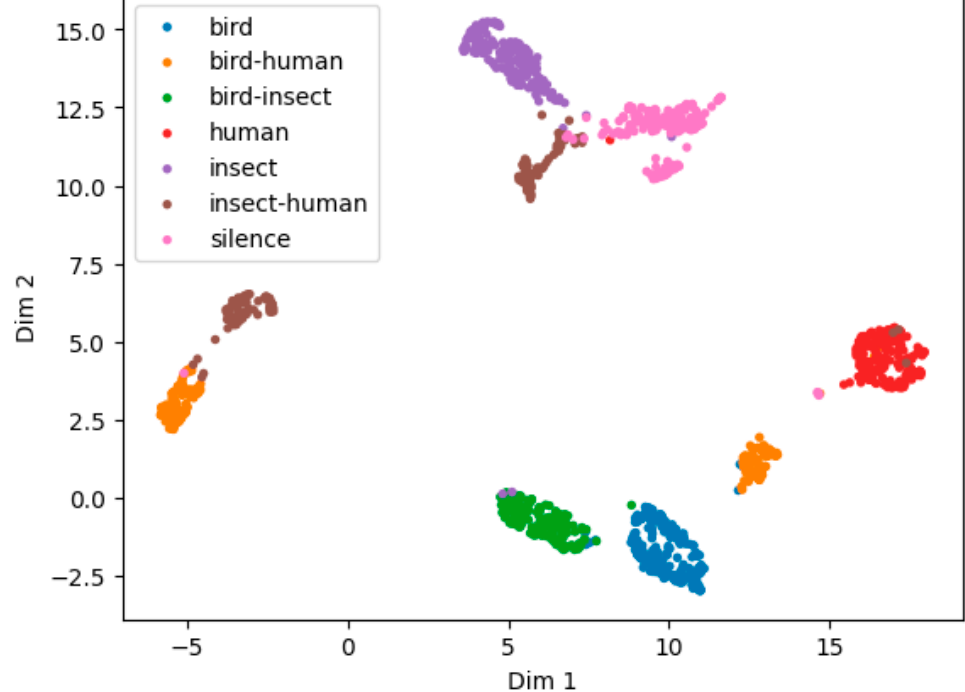
Figure 7. Visualization of the embedding features of the validation dataset.